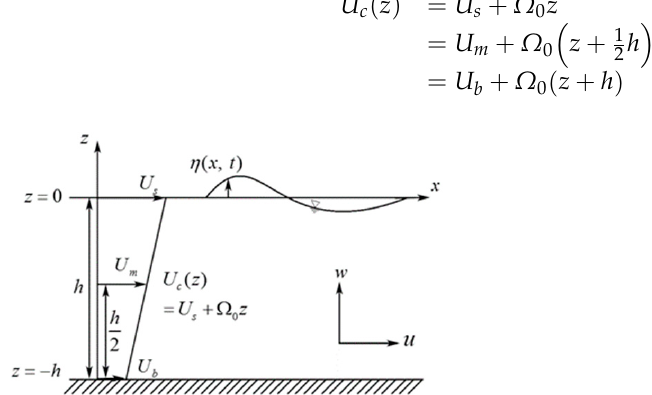
Figure 1. Definition sketch of the fluid domain and coordinate system.